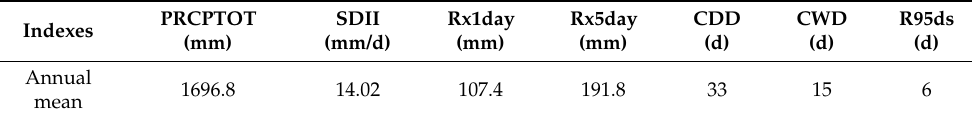
Table 2. Annual mean of precipitation indexes in Beijiang River